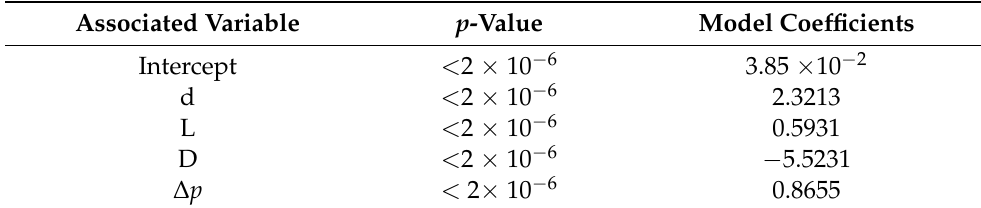
Table 5. Model coefficient and significance analysis: viscous